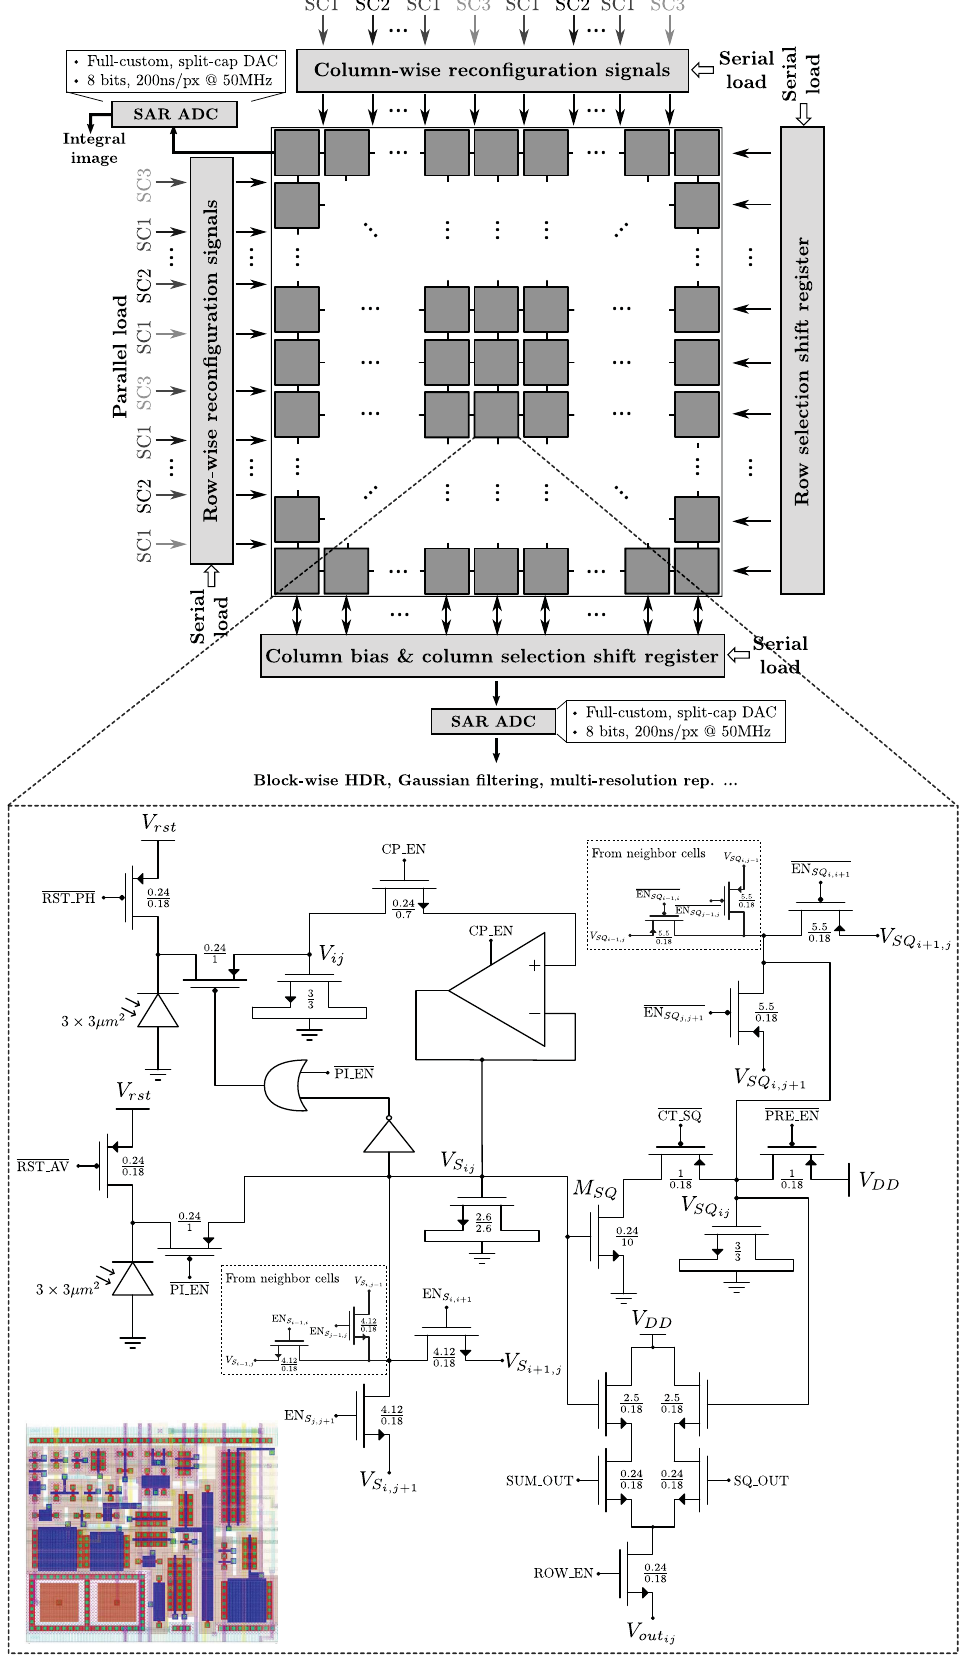
Figure 3. Architecture of the proposed focal-plane sensor-processor chip along with the schematic and layout of the multi-functional mixed-signal